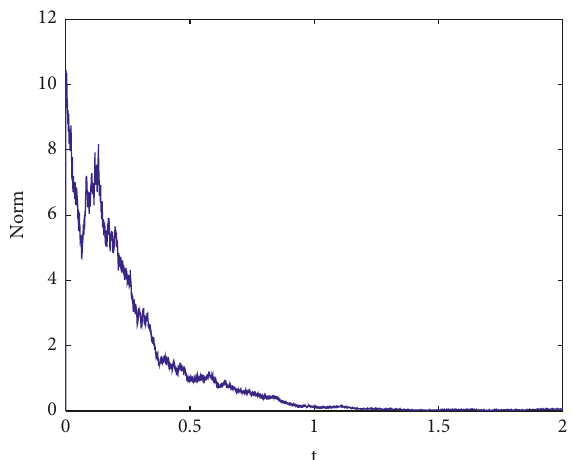
Figure 4: The L 2 ( 0 , 1 ) norm of the sample path of the solution u ( x,t ) to equation (29) with control